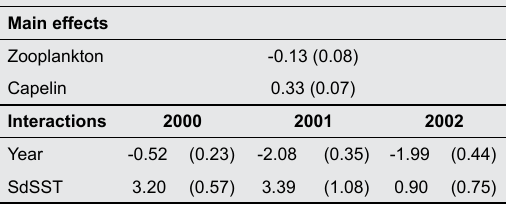
Table 7. Estimates (and SE) of variables in selected model describing Lagenorhynchus dolphin distributions in 2000, 2001 and 2002 within the study area. Residual deviance=319.13 (Null deviance=417.25), residual